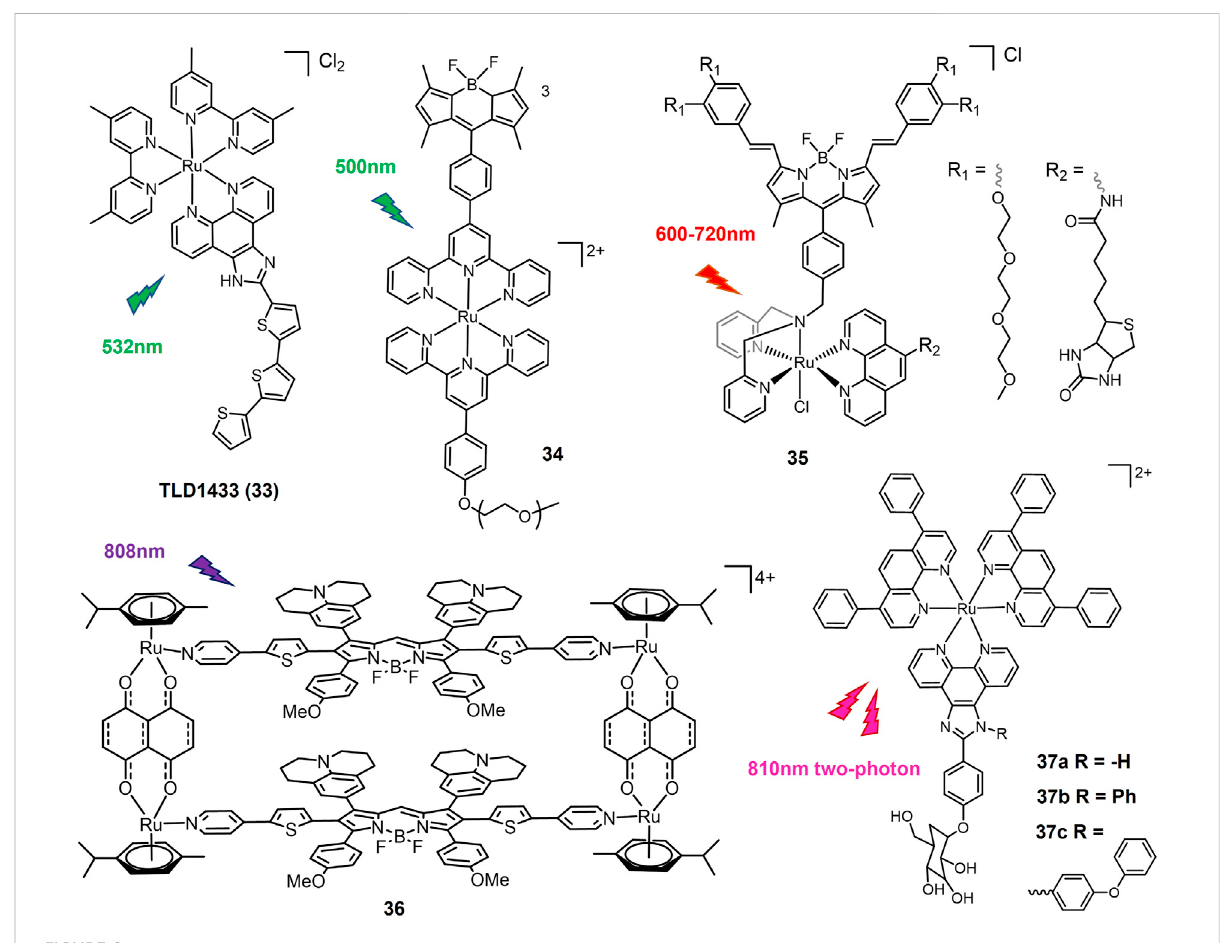
FIGURE 8 Light-responsive Ru(II) prodrugs as photosensitizers for